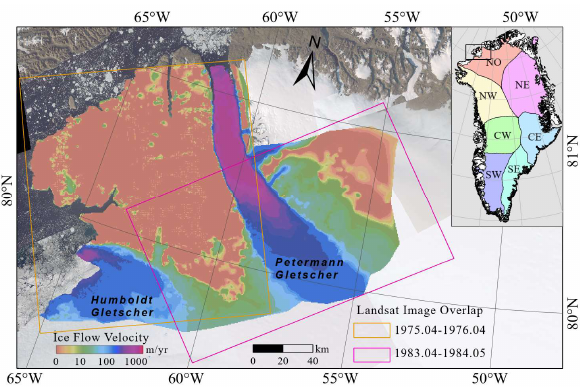
Figure 5 . Ice flow velocity mapping results for Petermann and Humboldt glaciers in North Greenland using early Landsat images (1975.04-1976.04 and 1983.04 -1984.05). The basin boundary is from Mouginot and Rignot (2019). The background is from Landsat Image Mosaic of Greenland (Chen et al., 2020).